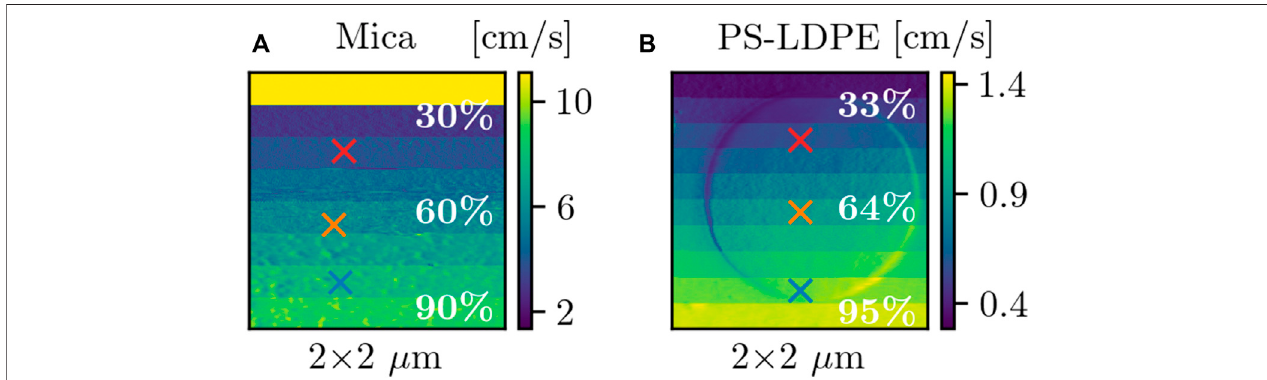
FIGURE 2 | Setpoint study on mica and a polymer blend. The amplitude of the fi rst drive frequency during a setpoint scan (setpoint values given in the image) of a mica surface (A) and a PS-LDPE polymer blend sample (B) . Each setpoint value corresponds to a percentage of the free amplitude. In (A) , the top domain is at a 120% setpoint value, corresponding to free response. The colormap depicts maximum tip velocity, where the velocity is reaching tens of cm/s. The interaction is analyzed at different pixels marked with X, and the force quadrature curves are shown with the corresponding color in Figure 3 .